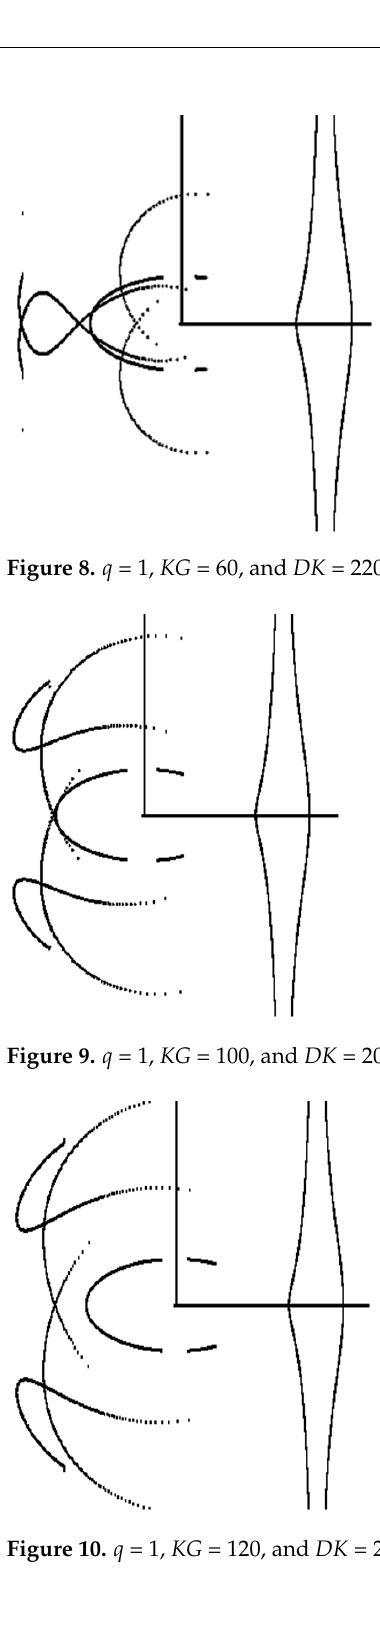
Figure 11. q = 1, KG = 120, and DK = 120. Figure 12. q = 1, KG = 120, and DK = 100. Figure 13. q = 1, KG = 130, and DK = 65